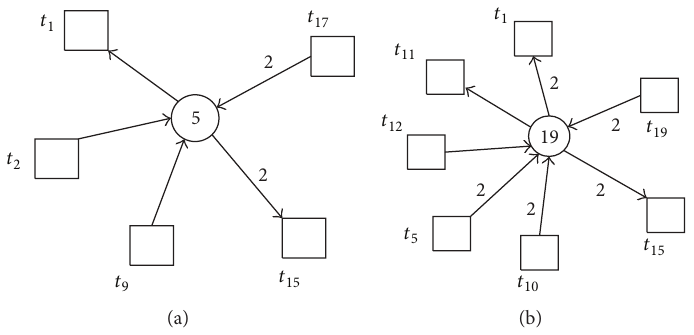
Figure 6: (a) Monitors 𝐸𝑉 𝑆